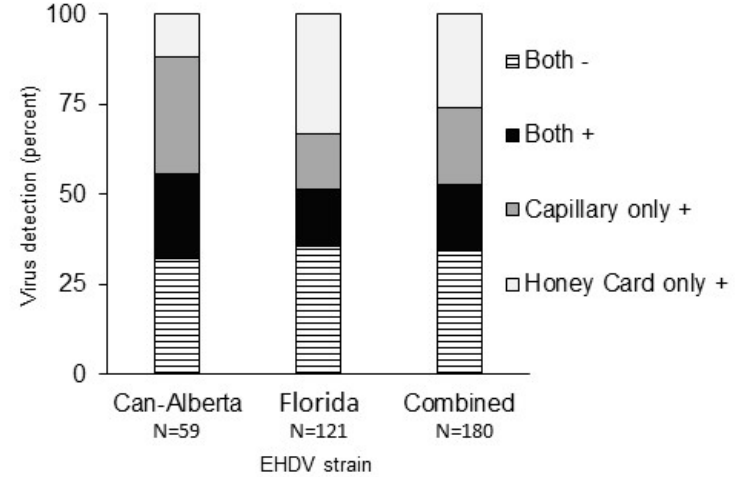
Figure 3. Virus detection by saliva collection method for two strains of EHDV-2 in Culicoides sonorensis as a percentage of total salivary assays completed. Consensus between the results of capillary assays and honey cards was reached for 52.8% of samples. Chi-square results indicated that positive detections were significantly dependent upon method, although this result was confounded by strain. Greater detections were made by capillary assays for the Can-Alberta strain and by honey cards for Florida strain infected midges.